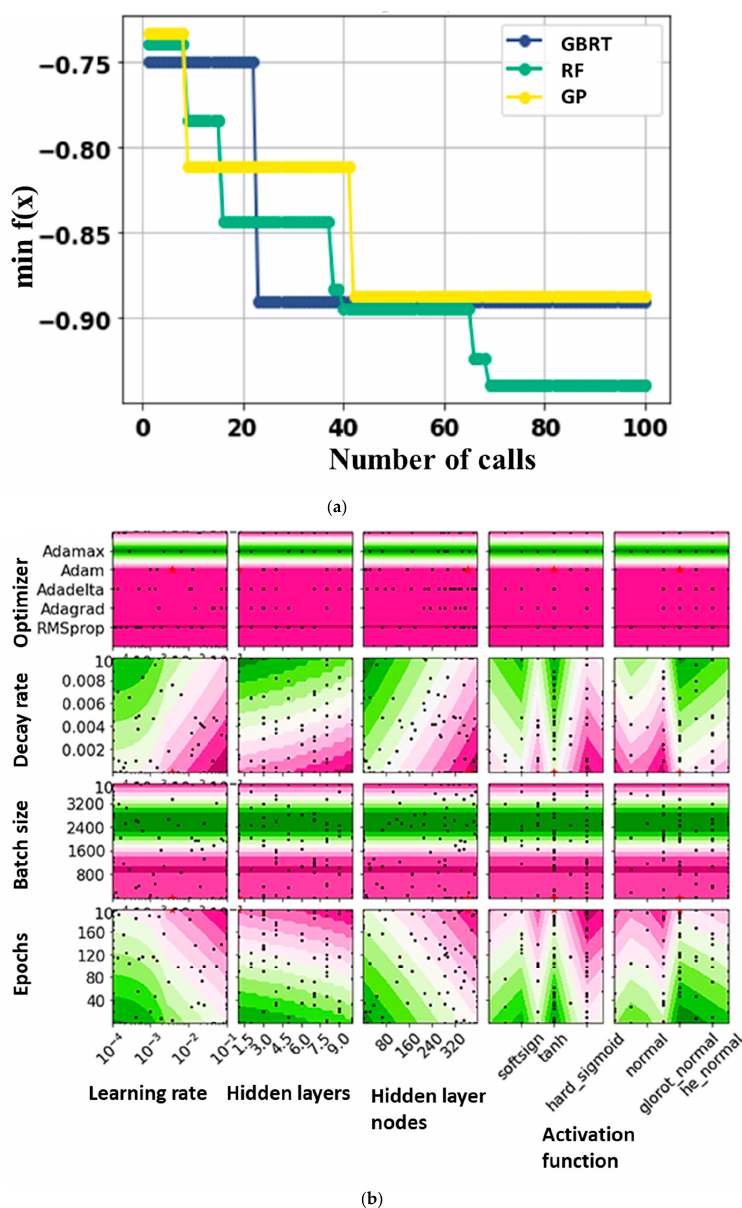
Figure 3. ( a ) Convergence plots and ( b ) hyper-parameters for the Bayesian surrogate models.